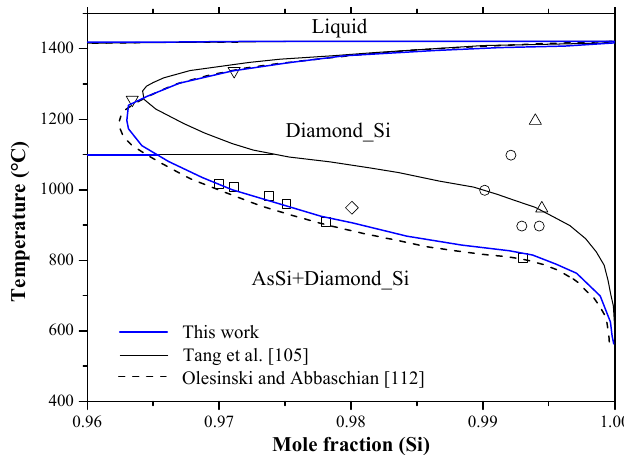
Figure 8. Magnified part of the As-Si phase diagram; —: [105]; ----: [112]; □ : [117]; (cid:53) : [118]; ♦ : [126]; ○ : [130]; Δ : [131].